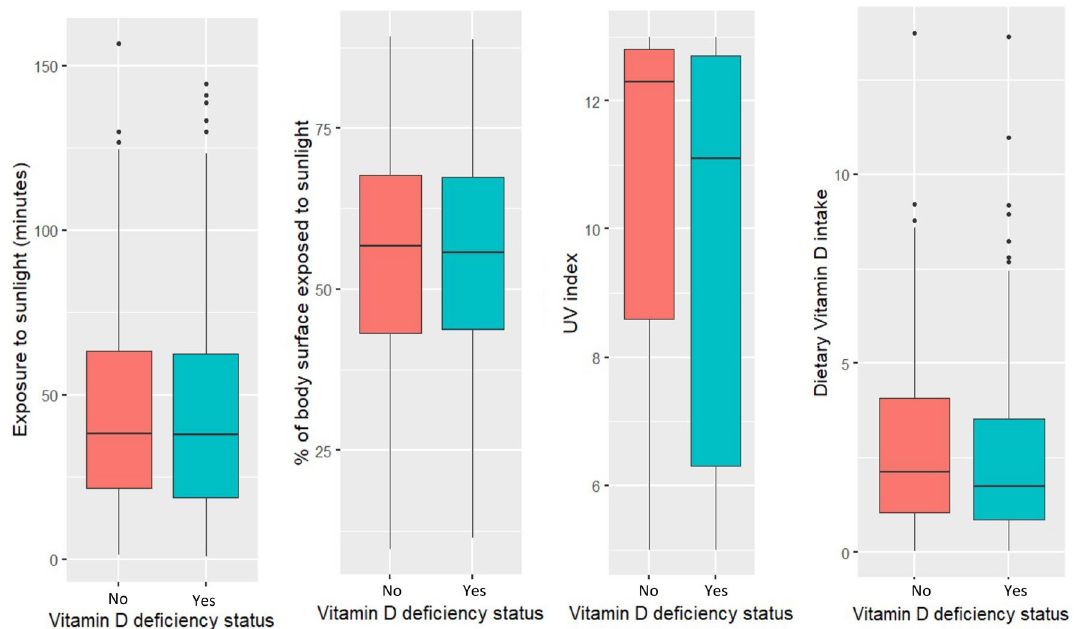
Figure 1. Serum vitamin D levels in relation to exposure to sunlight, percent of body surface exposed to sunlight, UV index, and dietary vitamin D intake.